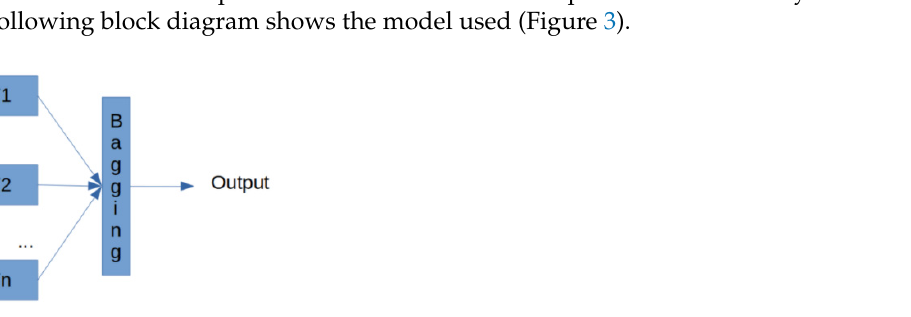
Figure 3. Model to detect the importance of the variables based on the decision trees used. Each DTnblock corresponds to a decision tree trained with an independent part of the data, and their ensemble is performed in the last block, bagging in inference time to give a consensuated